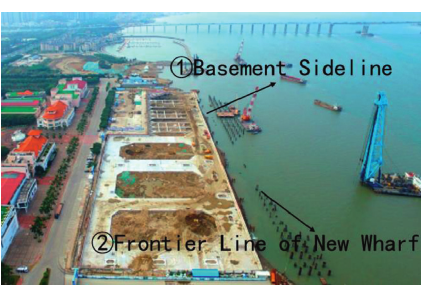
Figure 3: Environmental map of the foundation pit